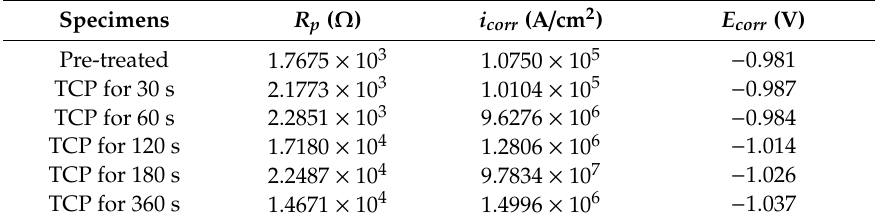
Table 1. Electrochemical parameters obtained from polarization curves shown in Figure